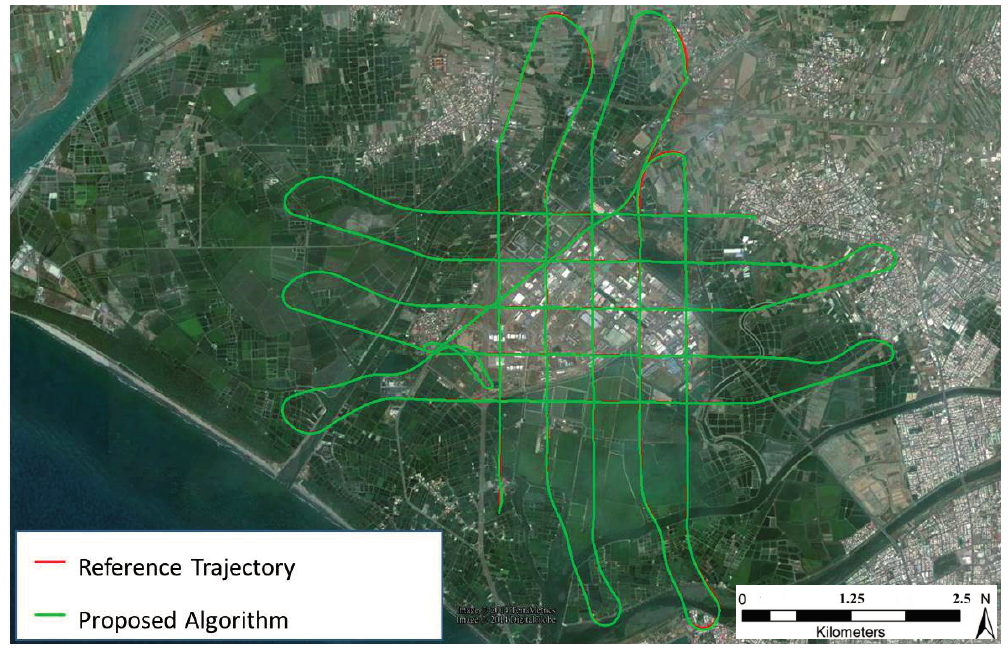
Figure 11. The trajectories of airborne test.